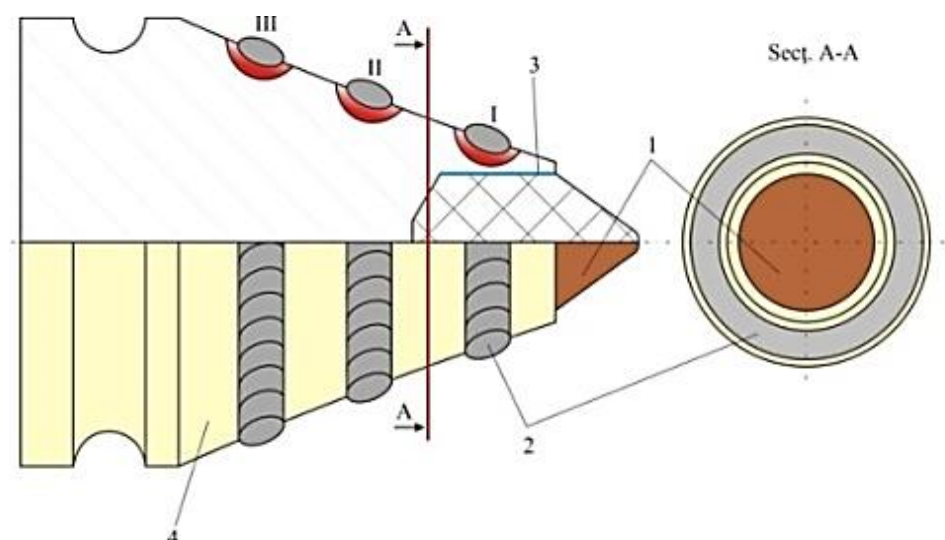
Figure 3. Concept of welding cord deposition on the frustoconical section of the tooth: (1) tungsten carbide tip; (2) annular cords achieved by metal deposition; (3) tungsten carbide tip brazing area in the front hole; (4) frustoconical section of the milling cutter tooth; zone I—first cordon; zone II—third cordon; zone III—second cordon.